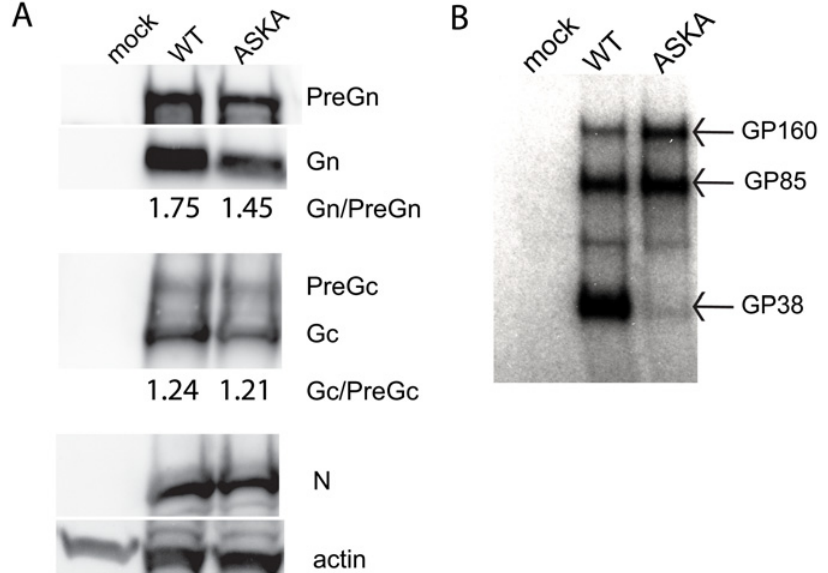
Fig 7. Effects of blocking furin cleavage on CCHFV glycoprotein maturation. (A) SW13 cells were infected with WT CCHFV or CCHFV-ASKA at MOI = 0.1, and immunoblots of structural proteins were performed on lysates collected 24 h post infection. Ratios of Gn:Pre and Gc:PreGc were obtained by densitometry of the bands (AlphaView; Alpha Innotech). (B) Immunoprecipitation of secreted non-structural proteins containing the GP38 domain with 6C11